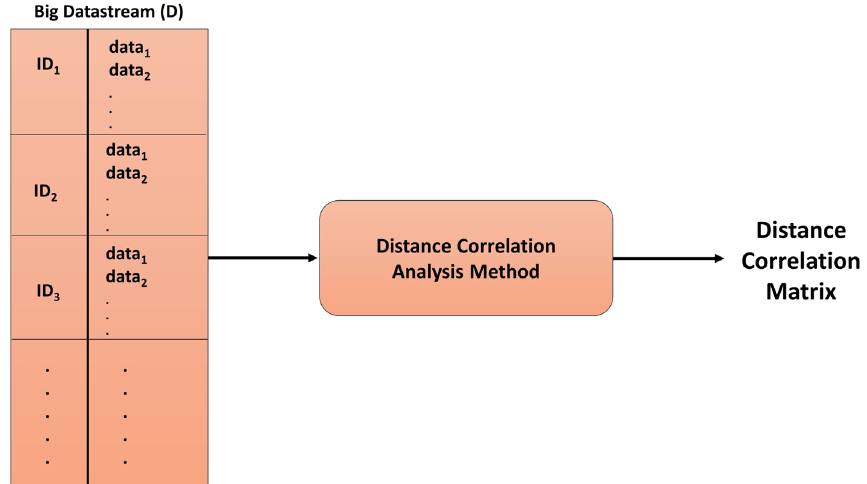
Fig. 3 Step 1 of proposed